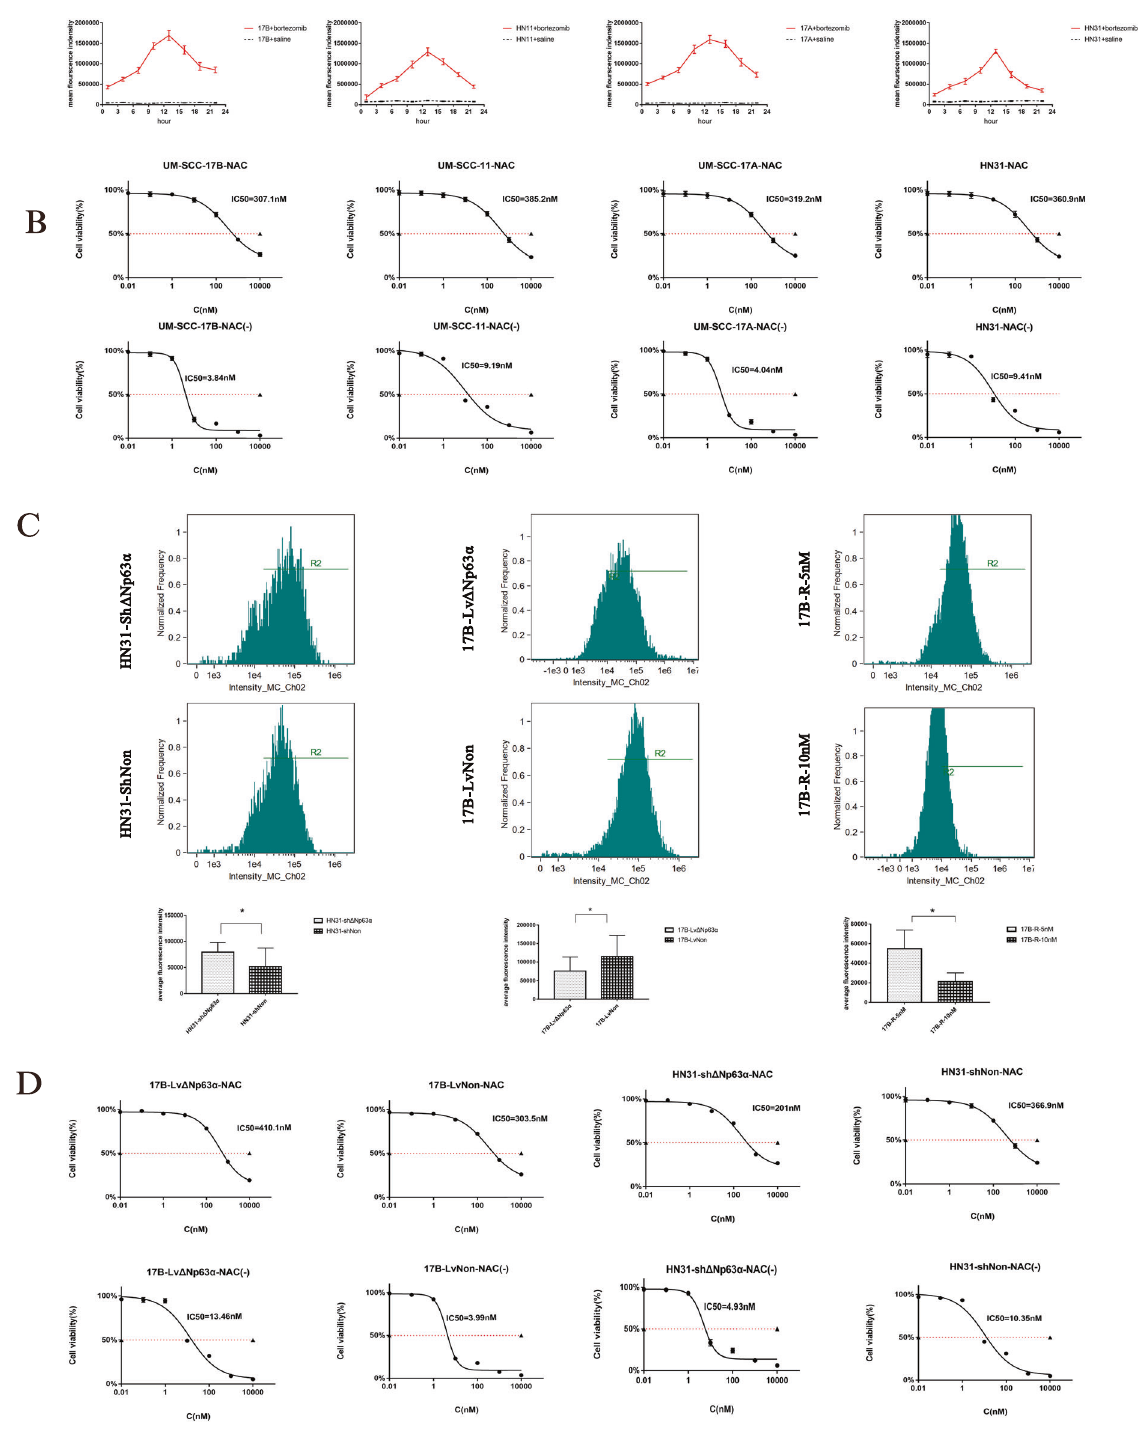
Fig. 5 Δ Np63 α regulates HNSCC cell to bortezomib resistance via ROS. A . Four strain cells were exposed to 10 nM bortezomib or to the same volume of PBS solution as a control. At the indicated times, cells were taken from culture and incubated in the presence of 10uM DCFH-DA for the determination of ROS generation. B . NAC was used to pre-protect UMSCC-17B, UMSCC-11, UMSCC-17A, and HN31 before exposure to bortezomib. IC50 was calculated using the CCK-8 assay. C . The histograms showed the DCF fl uorescence intensity for evaluating ROS levels following bortezomib treatment (4 h) in HNSCC cells. The values reported are the mean±sd of three independent transfections. Comparisons were carried out between HN31-sh Δ Np63 α and HN31-shNon, 17B-Lv Δ Np63 α and 17B-LvNon, and 17B-R-5nM and 17B-R-10nM. * P < 0.01. D . NAC was used to pre-protect 17B-Lv Δ Np63 α and HN31-sh Δ Np63 α before exposure to bortezomib. IC50 was calculated using the CCK-8 assay.